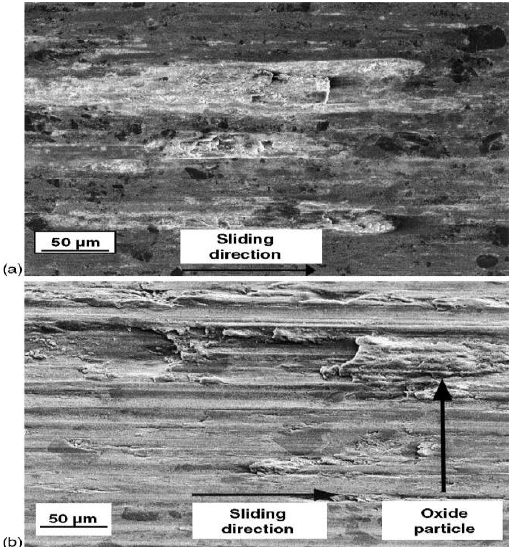
Figure 8. ( a ) Bright areas corresponds to iron oxide film on the worn surface of the Invar36–30 wt.%TiC composite. ( b ) Abrasive wear caused by iron oxide particles. Reproduced from [51], with permission from Elsevier, 2006.